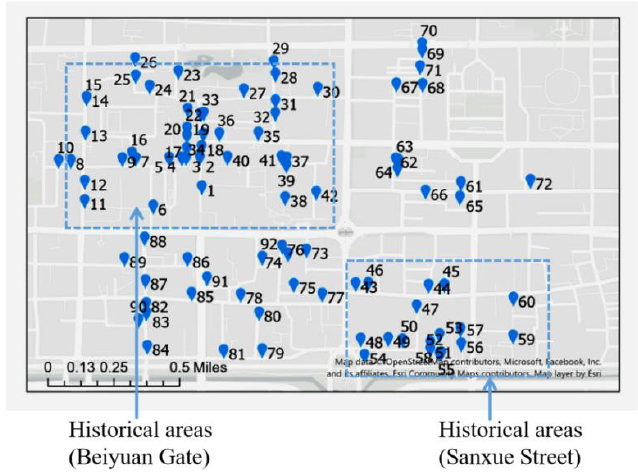
Figure 2. Selecting points in Xi’an (92 points, including 65 historical areas points).